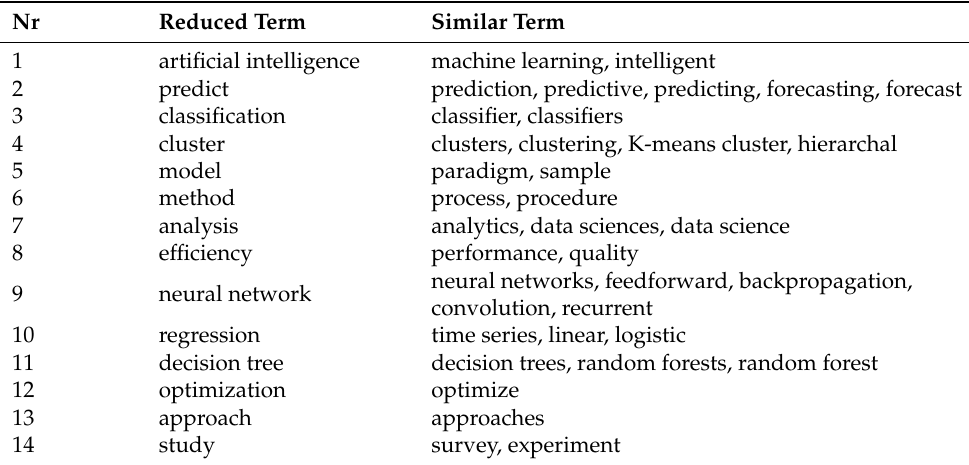
Table 6. Dictionary for the “intelligent computing models”